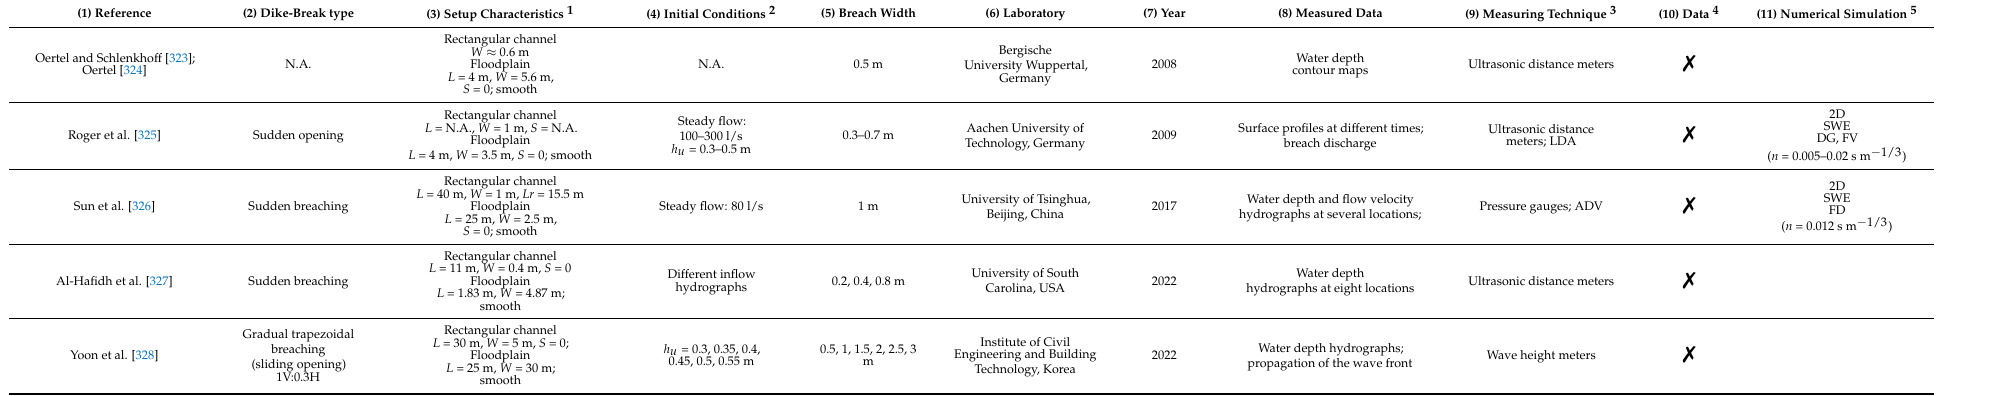
Table 1. Basic experimental investigations of fundamental dam-break wave physical characteristics.